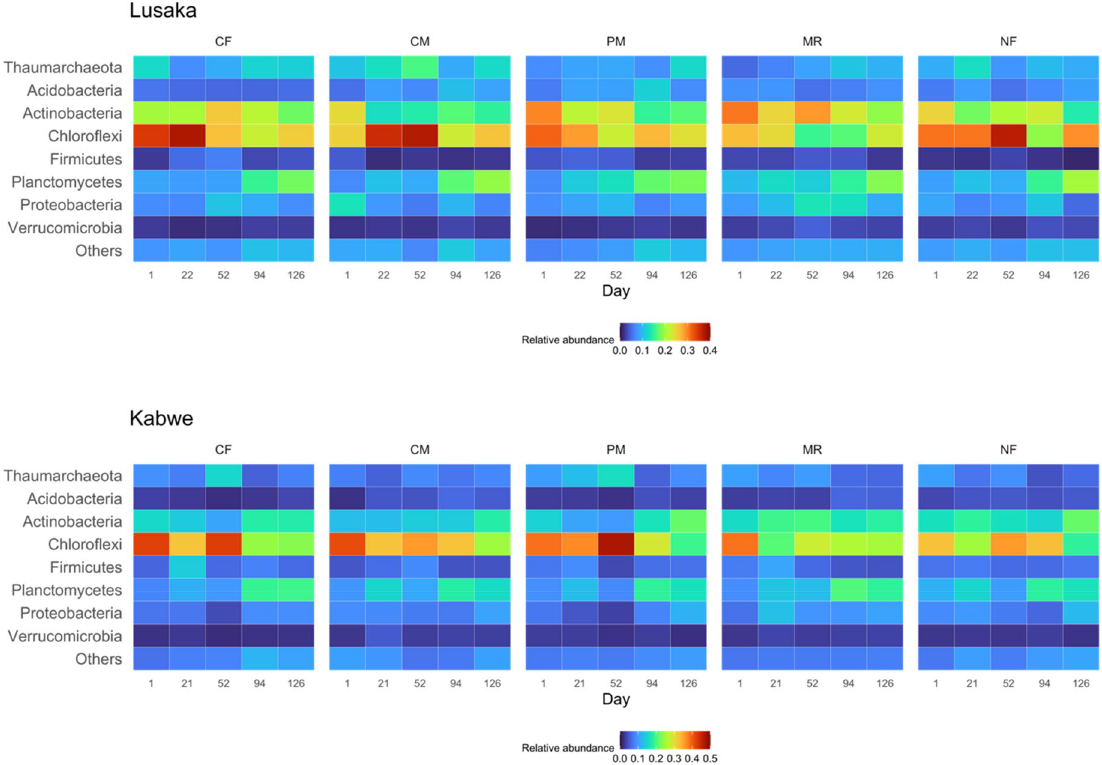
Figure 7. Distribution of the abundances of prokaryotic phyla in the Lusaka and Kabwe sites under different fertilizer treatments and sampling dates as visualized via heatmaps. CF: chemical fertilizer amendment, CM: cattle manure amendment, PM: poultry manure amendment, MR: maize residue amendment, and NF: no fertilizer amendment. The color intensity of the scale indicates the relative abundance of each phylum. Phyla with an abundance < 2% were grouped as